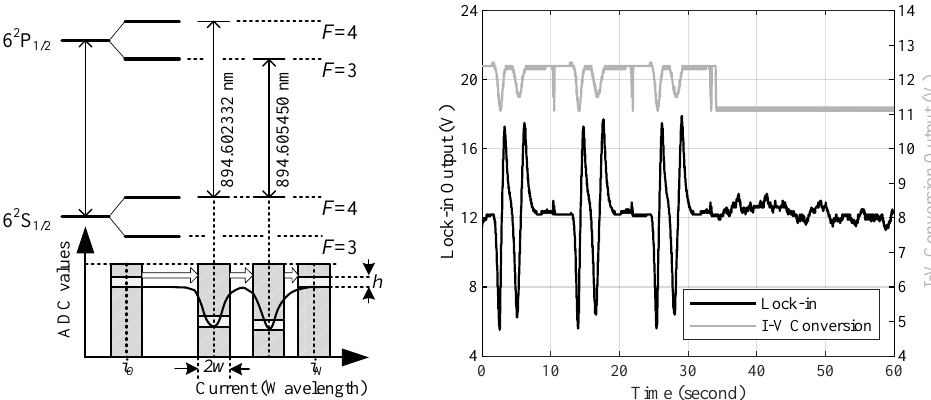
Figure 11. The schematic diagram of the fast frequency stabilization algorithm ( left ) and the actual process of frequency stabilization after using the algorithm ( right